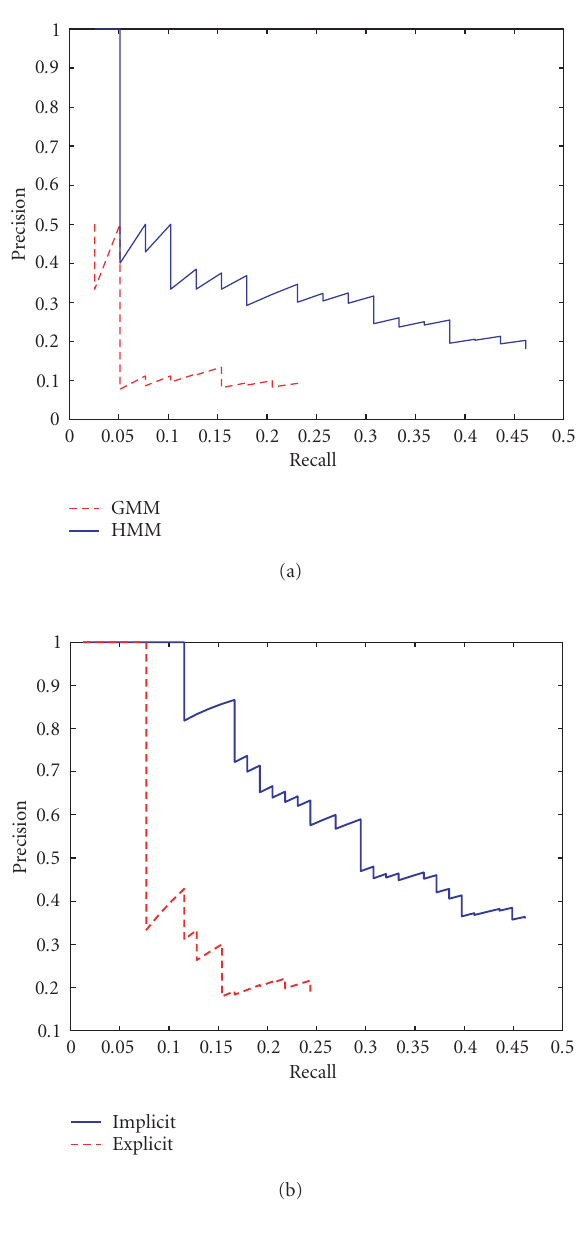
Figure 7: (a) E ff ect of duration modeling. Notice HMM outper- forms GMM. (b) Implicit versus explicit fusion. Notice that implicit fusion outperforms explicit